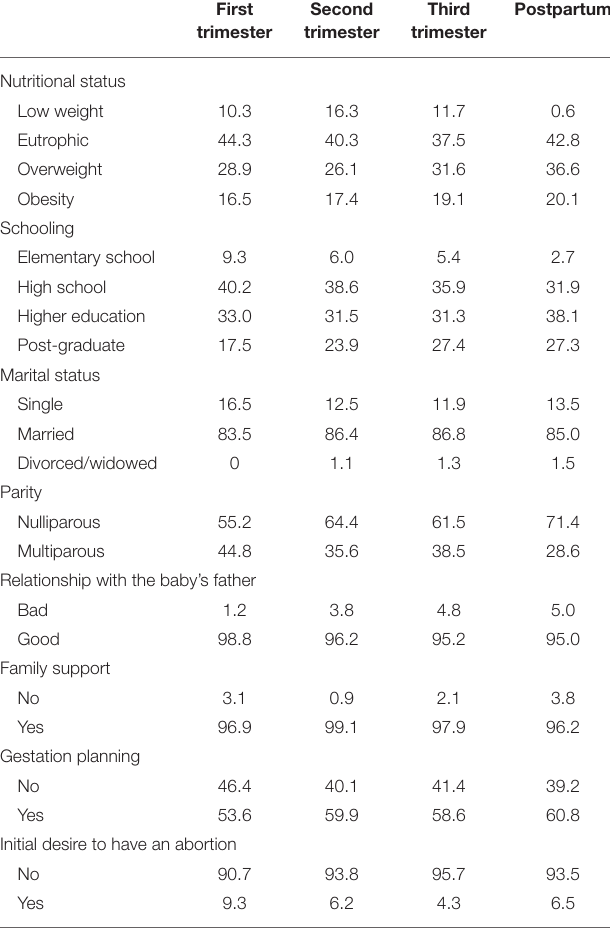
TABLE 1 | Relative frequencies for sociodemographic variable for each